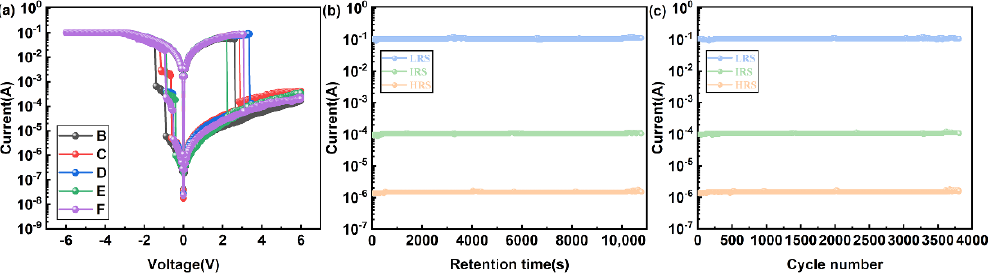
Figure 6. ( a ) I–V curves of the ITO/PF-BBO/Au/Al device containing 0–9 wt% of Au NPs; ( b ) reten- tion time; and ( c ) cycle number of device E. tion time; and ( c ) cycle number of device